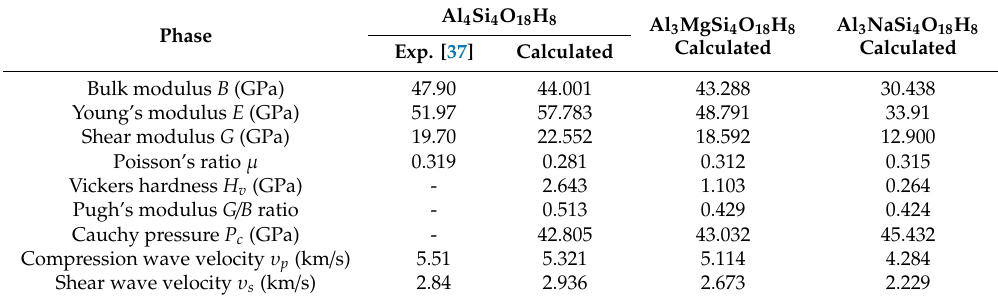
Table 5. The calculated bulk modulus ( B ), shear modulus ( G ), Young’s modulus ( E ), Poisson’s ratio ( µ